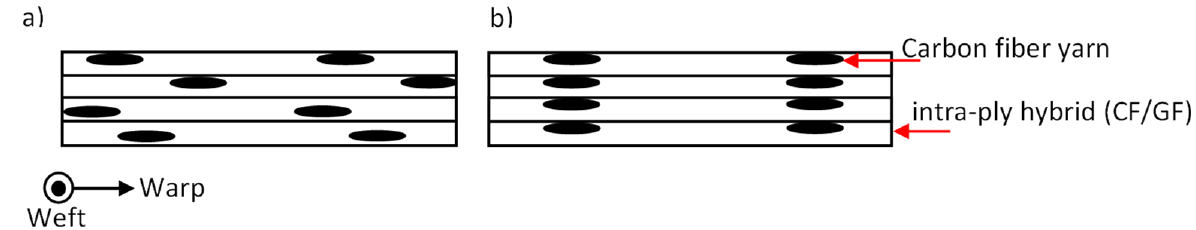
Figure 1. Schematic diagram of the cross-section of the intra-ply hybrid composite. ( a ) Carbon yarns were incorrectly aligned on top of each other due to misalignment of the plies, ( b ) the carbon yarns were integrated with glass fiber aligned perfectly on top of each other.